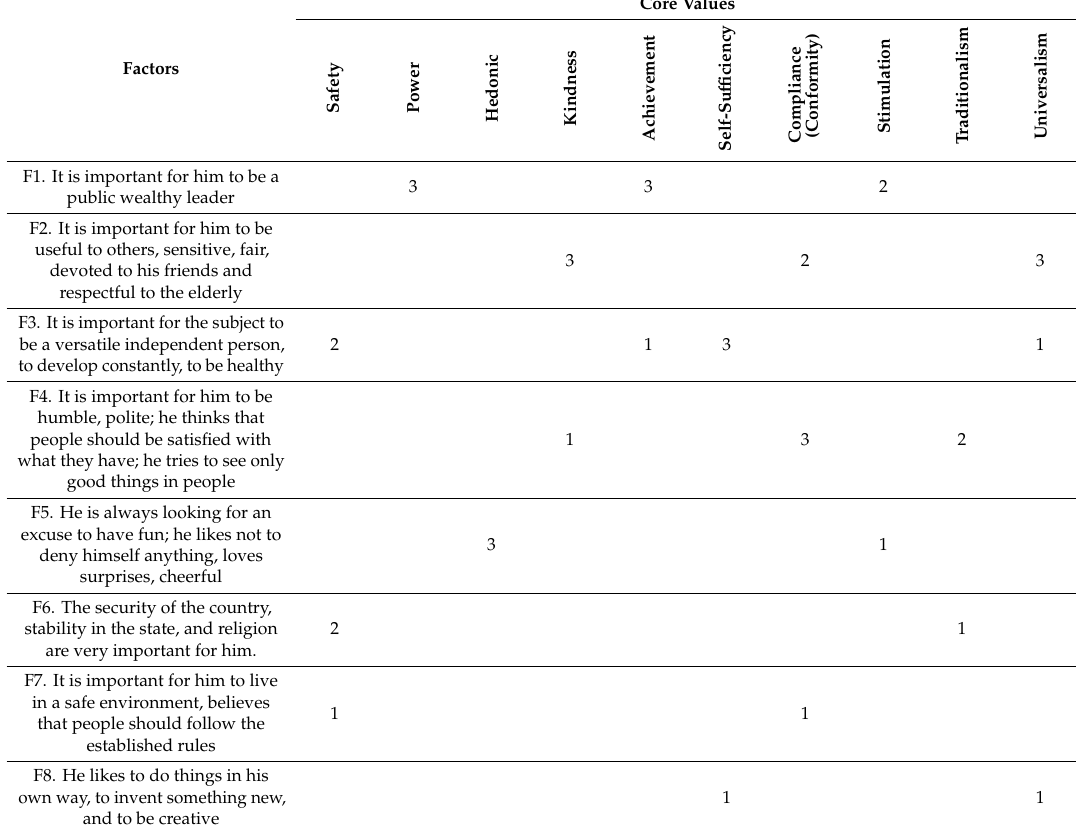
Table 5. Table of concordance of factors with basic human values of car owners (by number of corresponding initial variables).